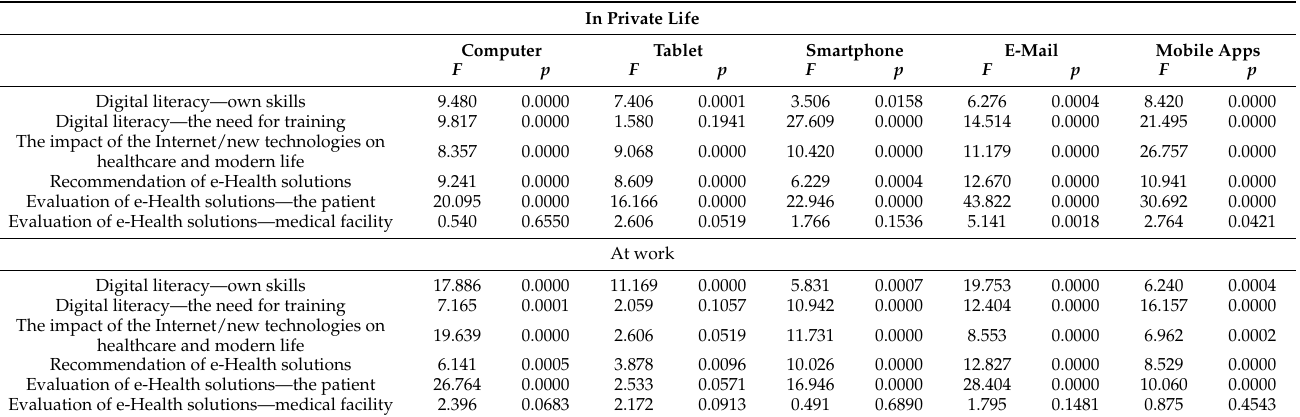
Table 4. Correlations between digital and e-Health variables, depending on using devices in physi- cians’ private and professional